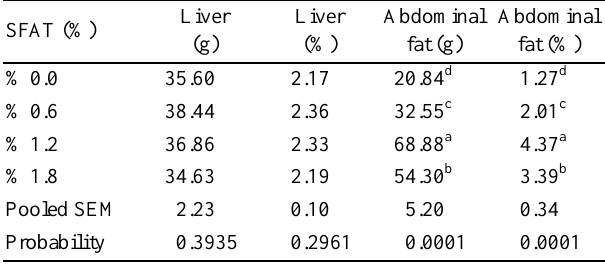
a-d Means with different superscripts letter within a column are significantly different